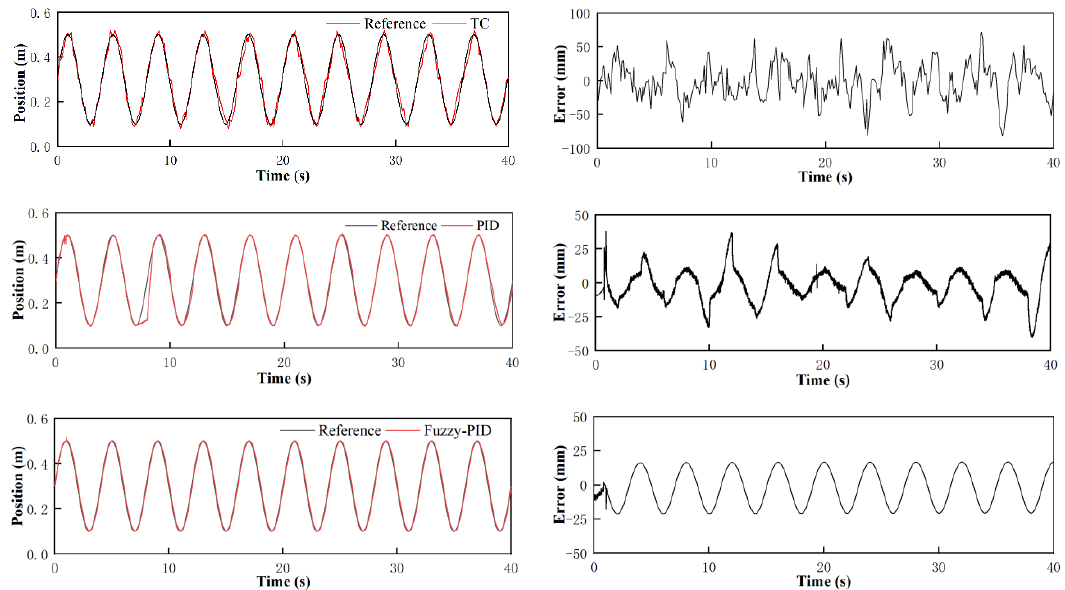
Figure 16. Experiments of normal-level trajectory motions (Constant Forging).